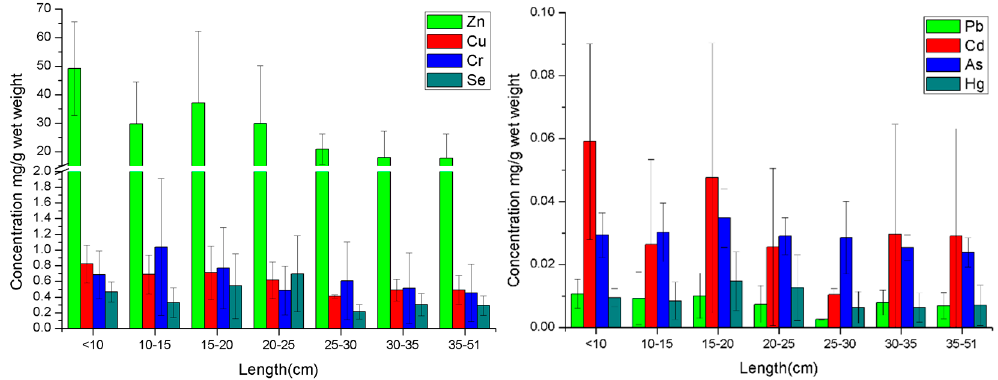
Figure 2. The concentration of metals in different length ranges of fish.